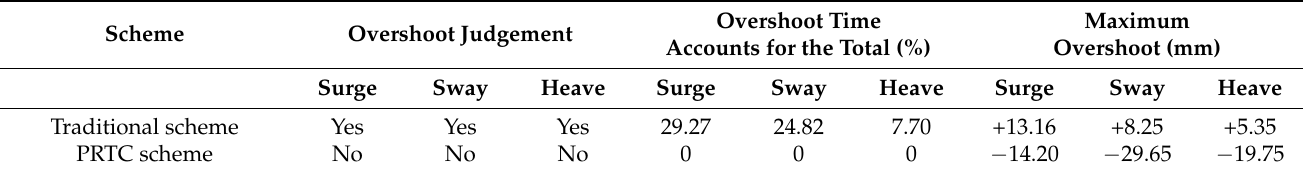
Table 1. Performance of PRTC scheme and traditional scheme in overshoot.